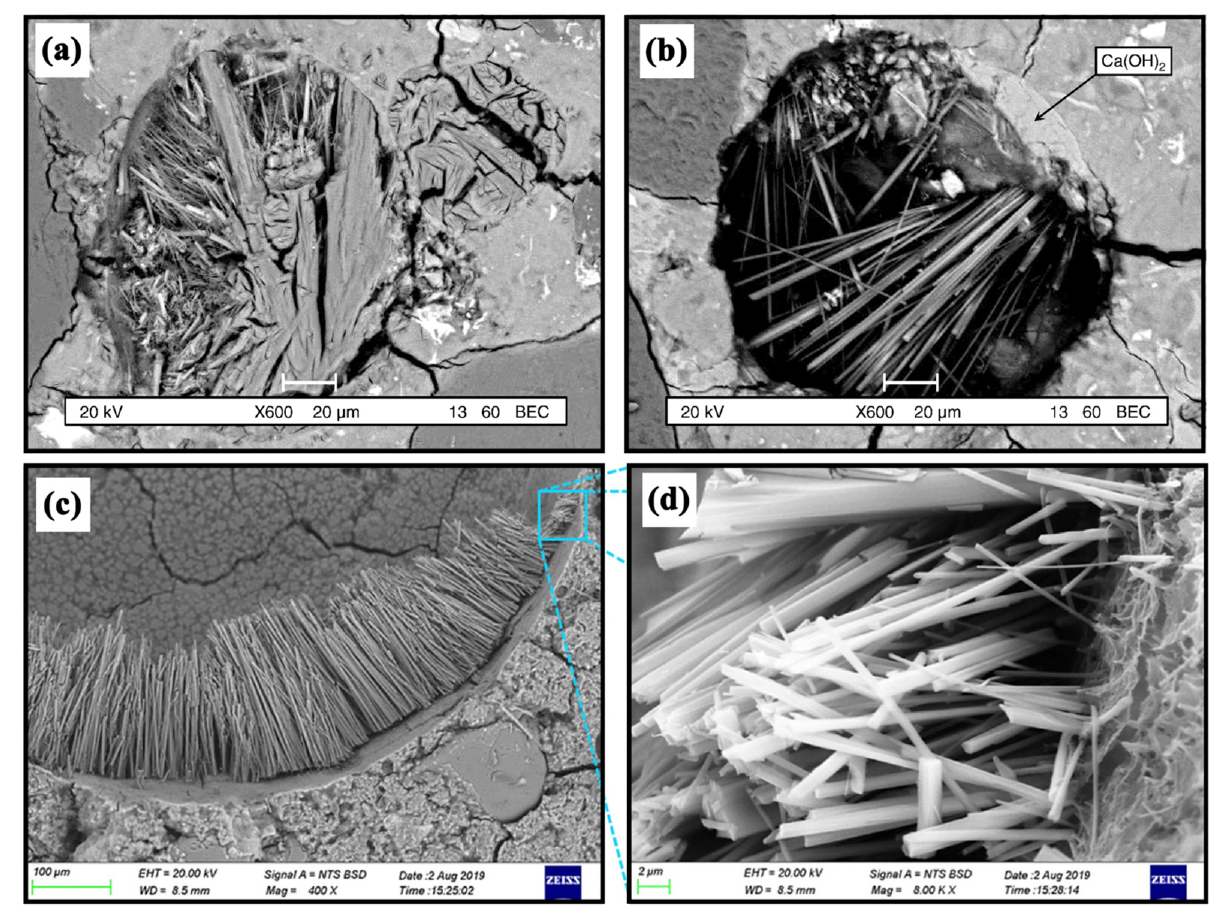
Figure 11. The secondary Ettringite found by Rosenqvist et al [45] and Neumann et al. [46]. ( a , b ) The microstructure of concrete after 55 years of exposure to river water. Reprinted/adapted with permission from Ref. [45]. 2017, Elsevier. ( c , d ). The microstructure of concrete after 40 years of exposure to river water. Reprinted/adapted with permission from Ref. [46]. 2021, Elsevier.